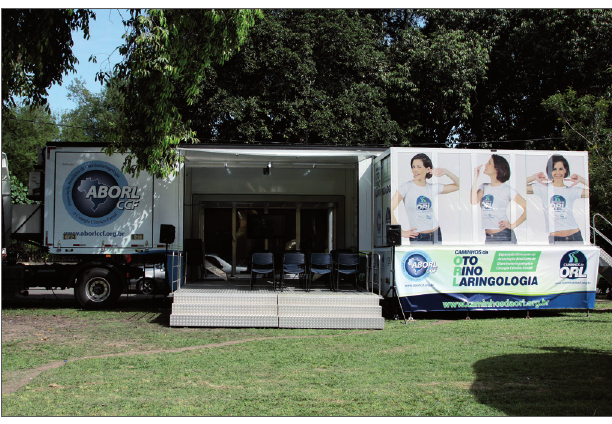
Figura 1. Unidade móvel aberta com miniauditório.